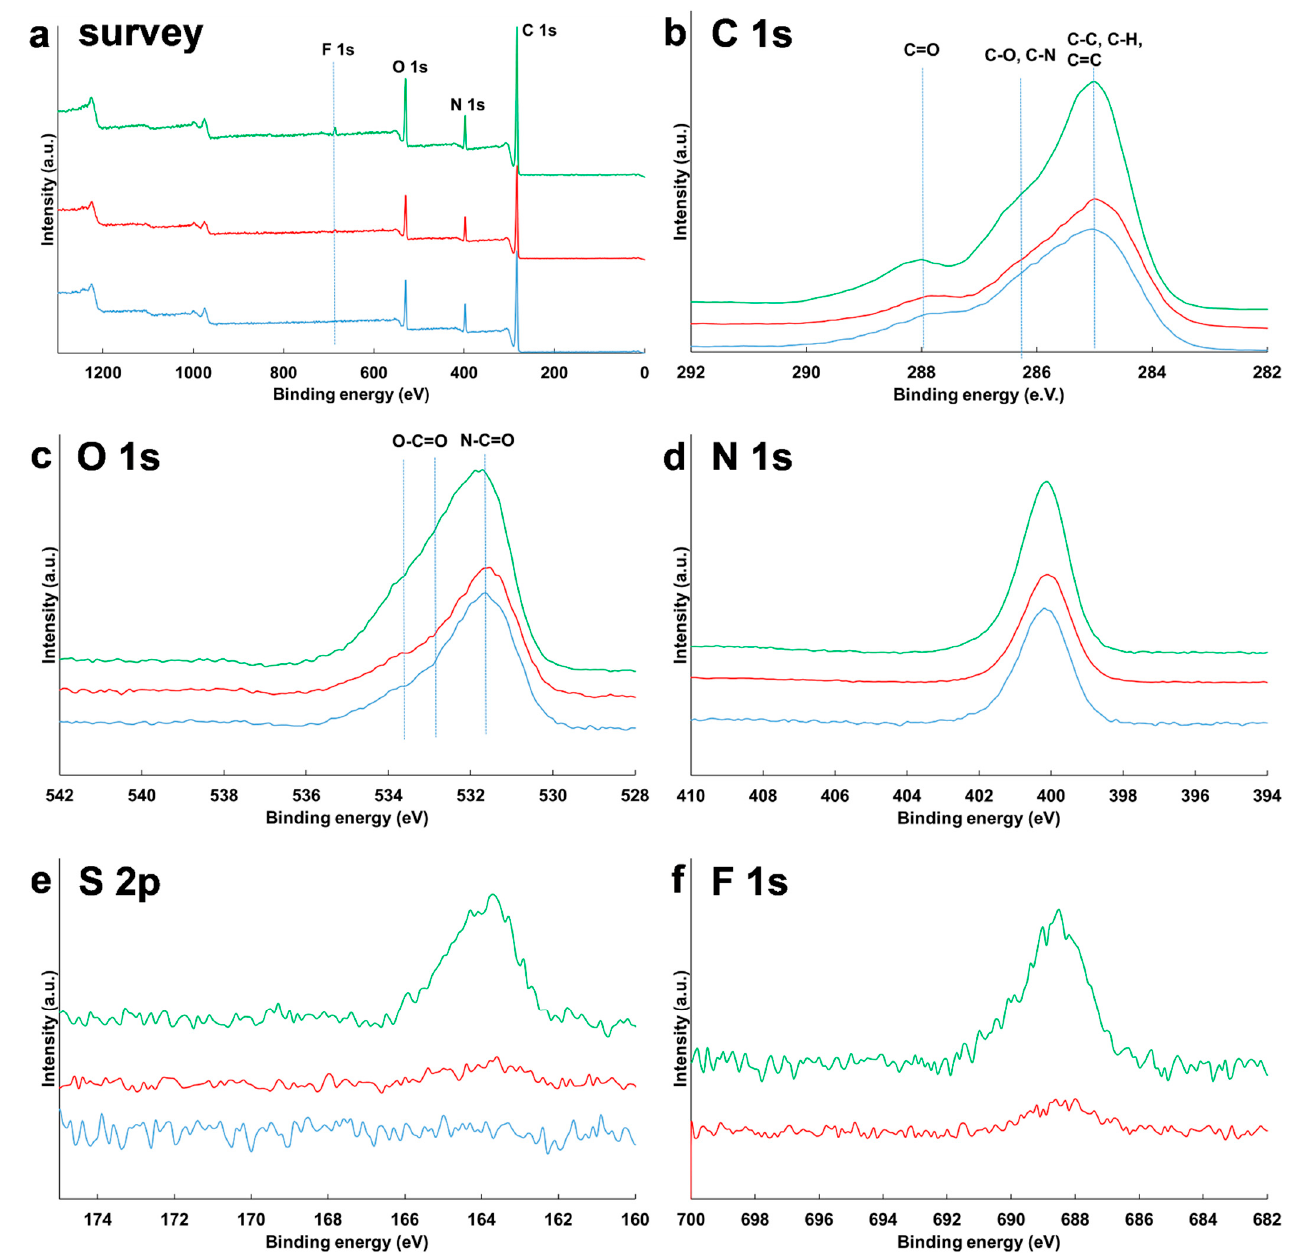
Figure 7. High resolution XPS spectra of SqCsA (blue), SqCsA/ 3a 95:5 (red), and SqCsA/ 3a 75:25 (green) are represented for survey spectra ( a ), Carbon C 1s ( b ), Oxygen O 1s ( c ), Nitrogen N 1s ( d ), Sulfur S 2p ( e ), and Fluorine F 1s ( f ).